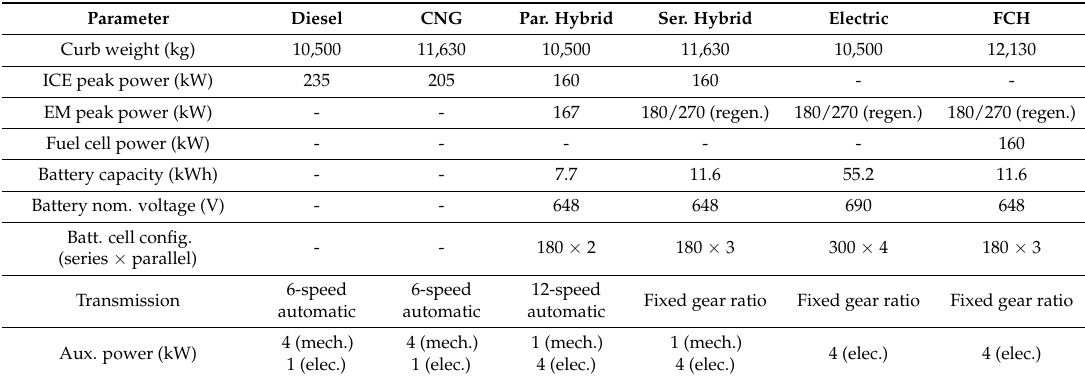
Table 5. City bus simulation model